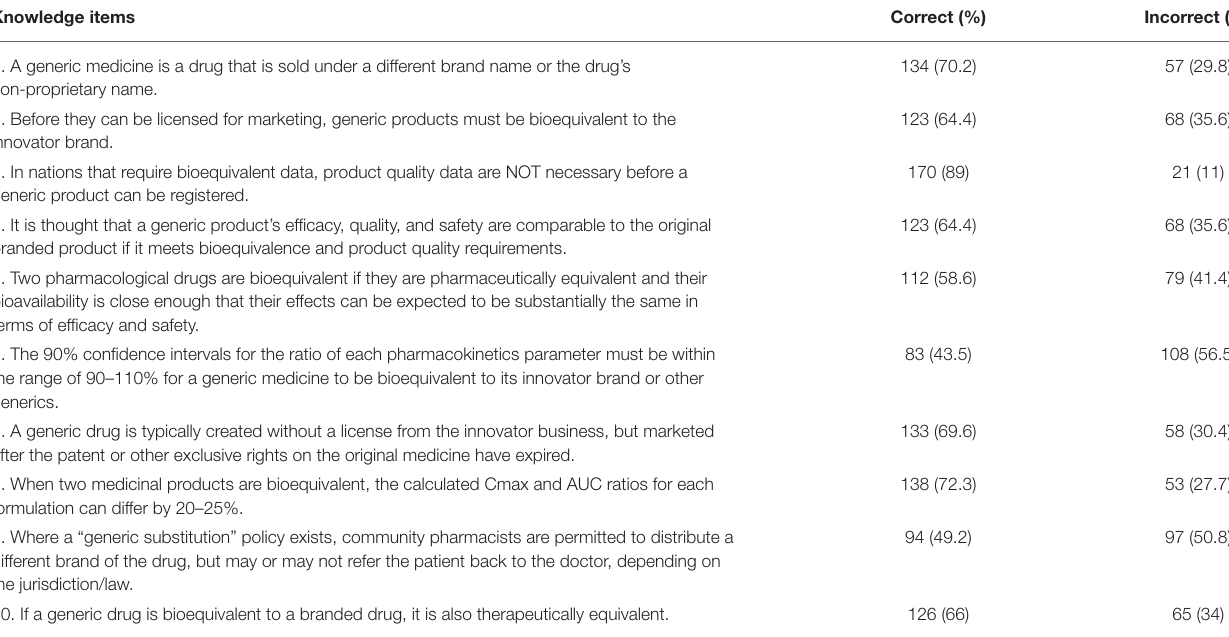
TABLE 1 | Knowledge of Saudi PharmD students on generic medicines ( n = 193).